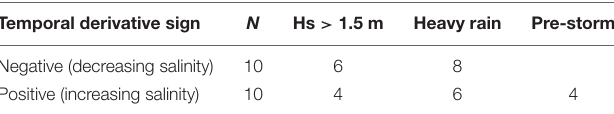
TABLE 1 | Mechanisms of sandbar breaches: 20 sandbar breaches identified by large day to day change of the bottom salinity 350 m upstream from estuary mouth.